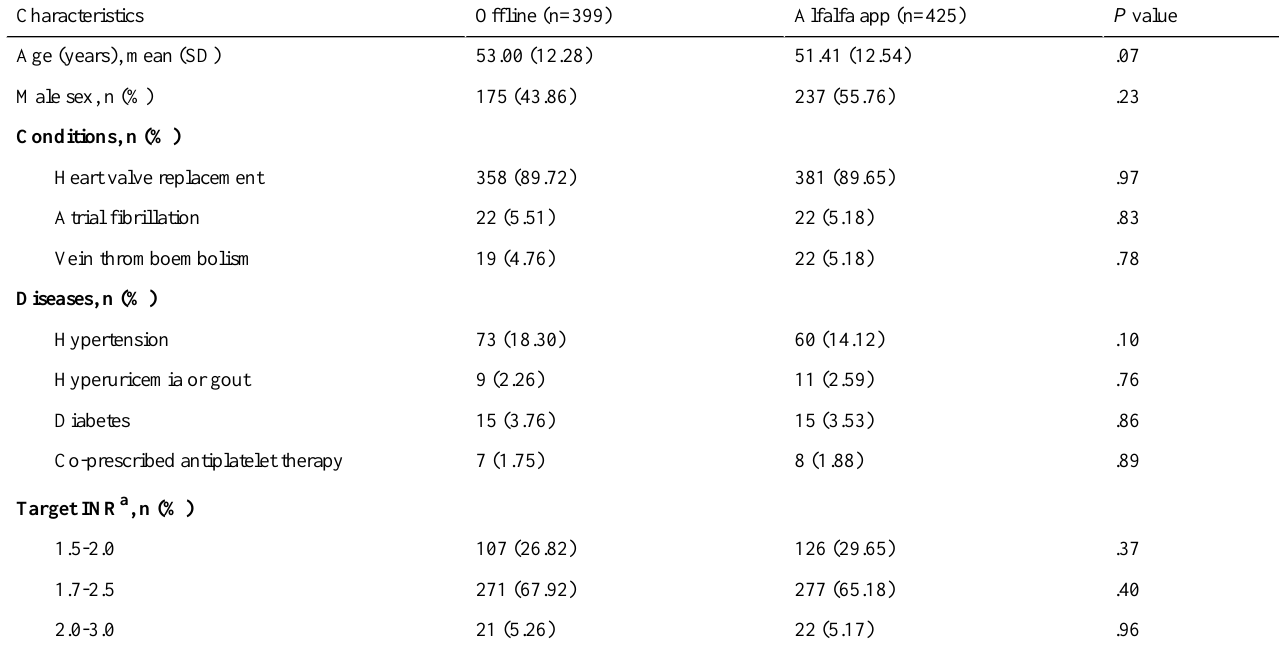
Table 1. Patient characteristics.